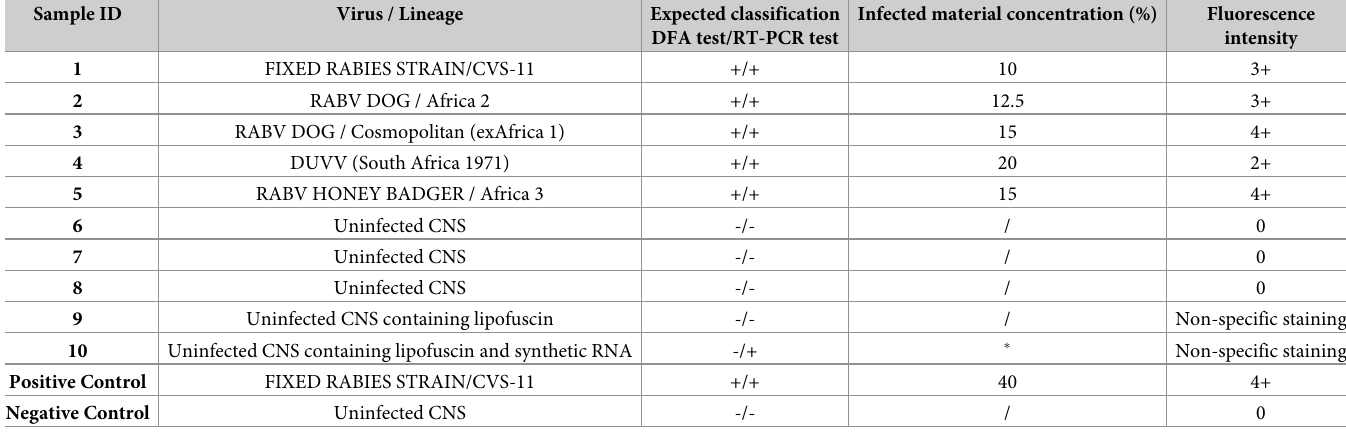
Table 1. Panel composition and expected classification of samples. Panels included ten freeze-dried blinded samples, one positive and one negative control. Five out of ten samples were expected to turn out positive through DFA test, whilst six out of ten samples in the panel were expected to be positive using the RT-PCR test. RABV (Rabies virus) and DUVV (Duvenhage virus), all belonging to phylogroup I, were selected for the exercise. Sample